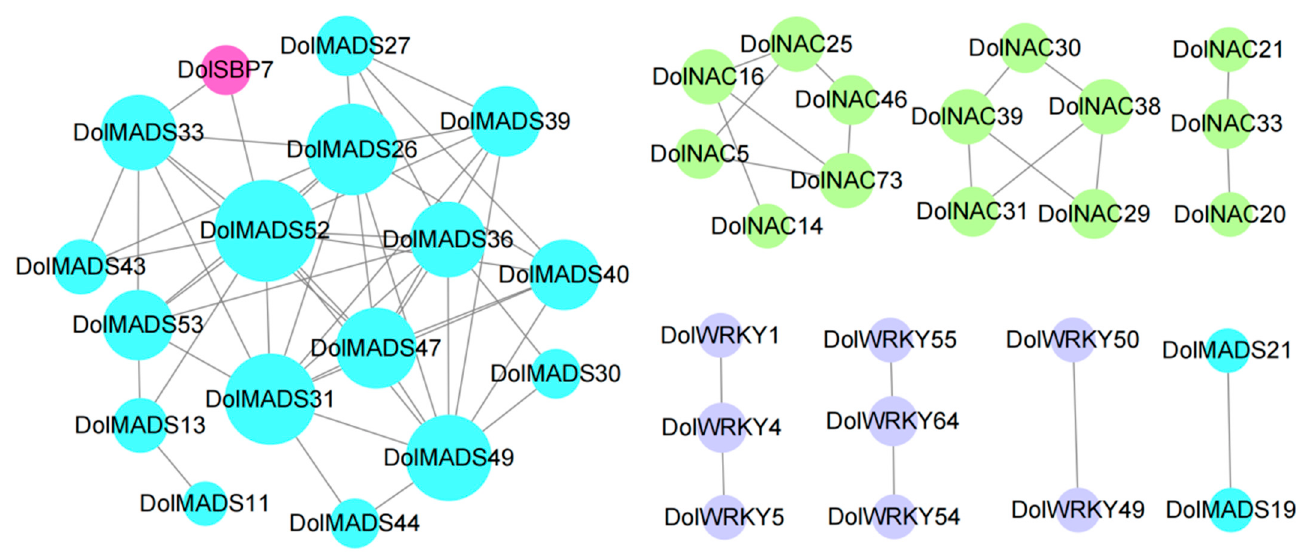
Figure 12. Protein interaction networks for DolMADSs, DolWRKYs, DolNACs, and DolSBPs. The nodes represent DolMADSs, DolWRKYs, DolNACs, or DolSBPs, the edges were the interaction between two proteins. The size of the circles from small to large, indicates an increasing number of interacting proteins. Different colours represent different gene families.